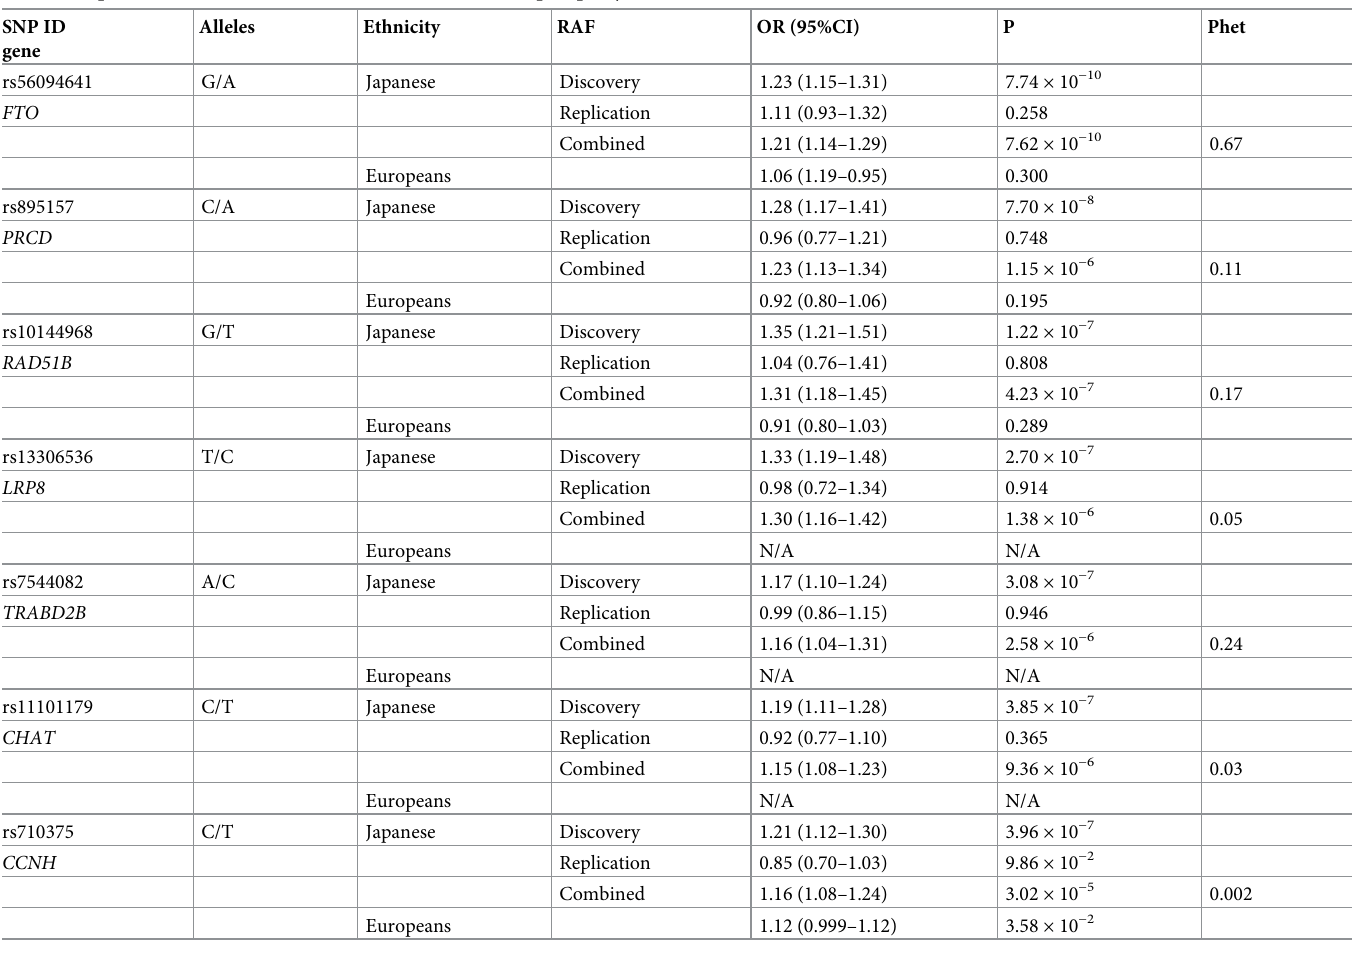
Table 3. Replication studies for 7 loci associated with diabetic